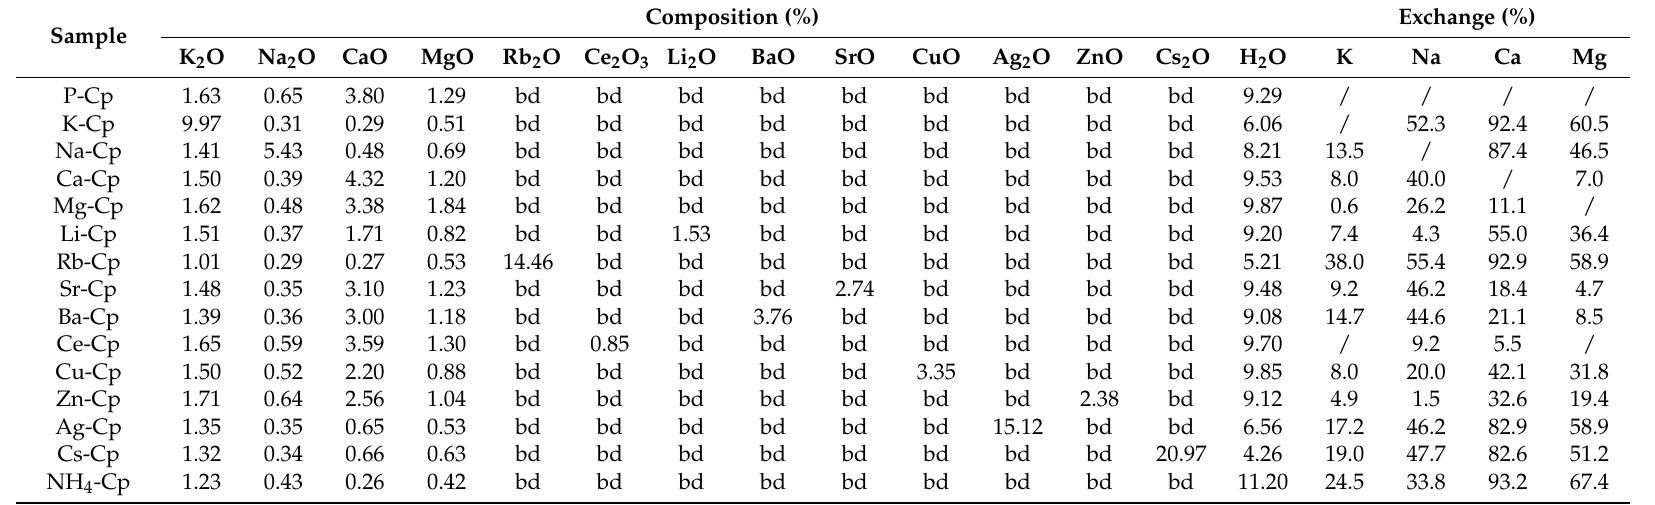
Table 1. Composition (wt.%) of the purified and modified